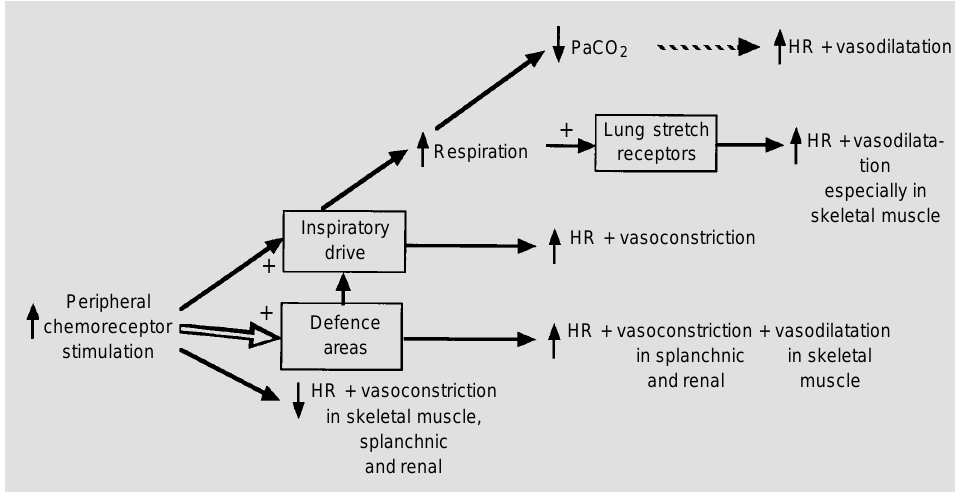
Figure 1 - Schematic diagram showing the primary and sec- ondary effects of selective stim- ulation of peripheral chemore- ceptors. + indicates an excita- tory effect. Broken arrow indi- cates direct or local rather than reflex effects. Open arrow to defence areas indicates a higher threshold effect. For further de- tails see text. HR, Heart